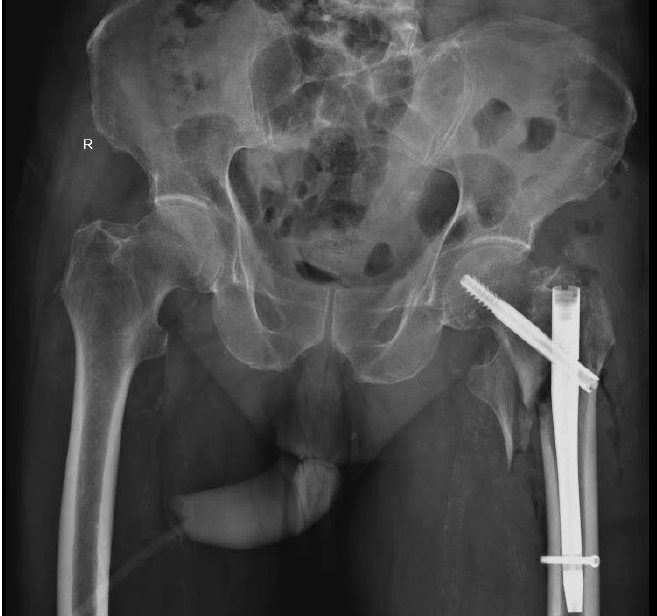
Figure 6. Post-surgery pelvic X-ray, anteroposterior incidence. Description: male subject, urinary catheter. Right hip with minimal narrowing of the joint space. Left hip with osteosynthesis material (intramedullary rod) in the proximal segment of the femur with distal nailing. Bone fragment with dorsal and internal displacement. Coxo-femural spaces maintained. Acetabular surfaces with sclerosis.